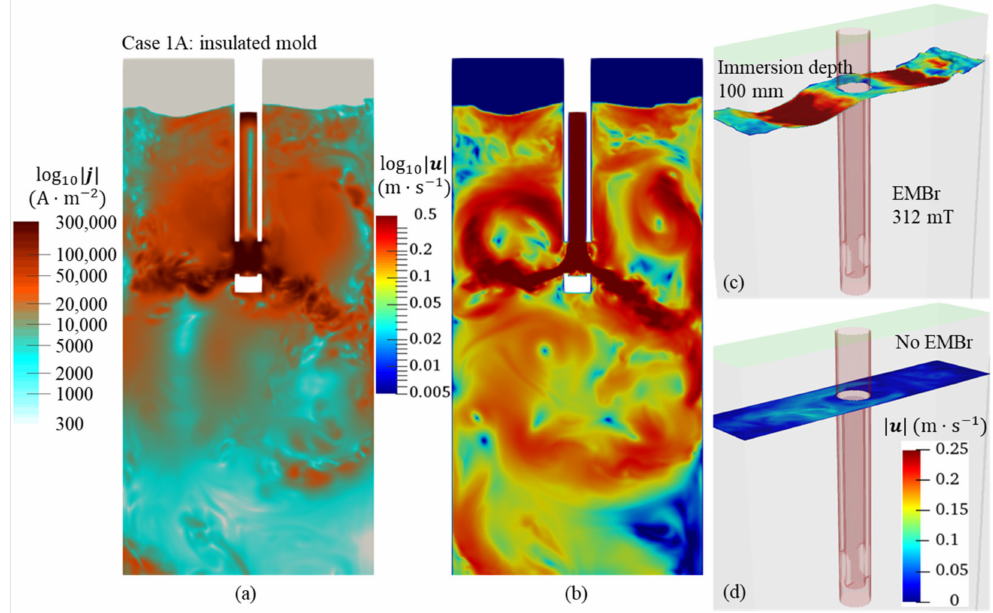
Figure 7. Meniscus flow for Case 1A: ( a ) induced e-current density and ( b ) melt velocity (midplane); ( c ) interface velocity with EMBr compared with ( d ) Case 0A without